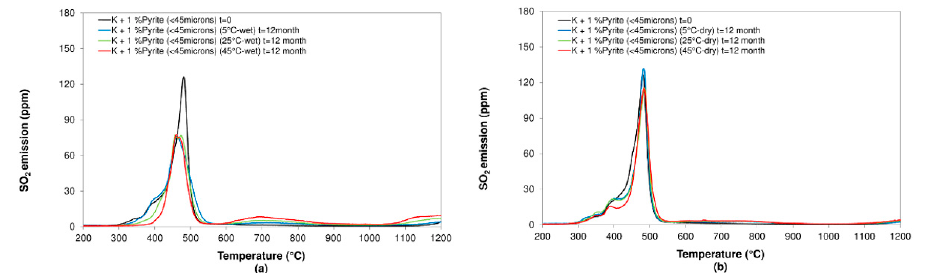
Figure 7. Evolution of the sulfur dioxide emission of the pyrite composition in ( a ) a wet environment and ( b ) a dry environment .